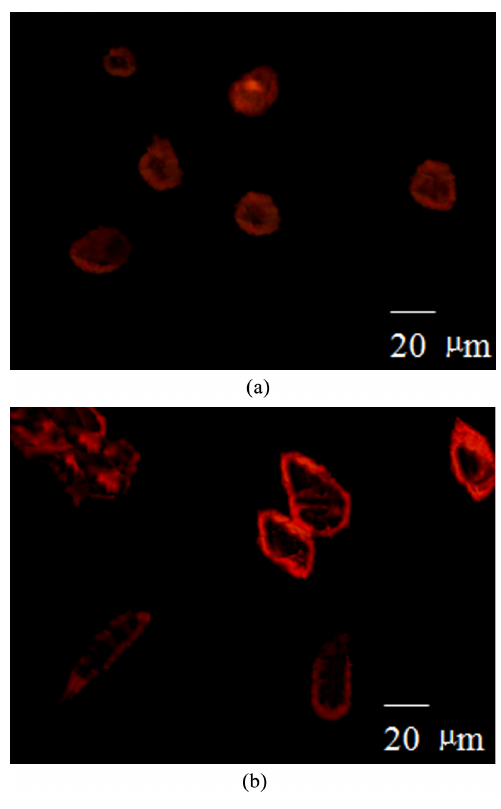
Figure 5. CLSM micrographs of MC3T3-E1 cells adhering to the different surfaces of the HCP scaffolds embedded with SS loaded collagen microspheres after 5 h of inoculation: (a) cells seeded on the loose surface of the scaffolds. (b) cells seeded on the dense surface of the